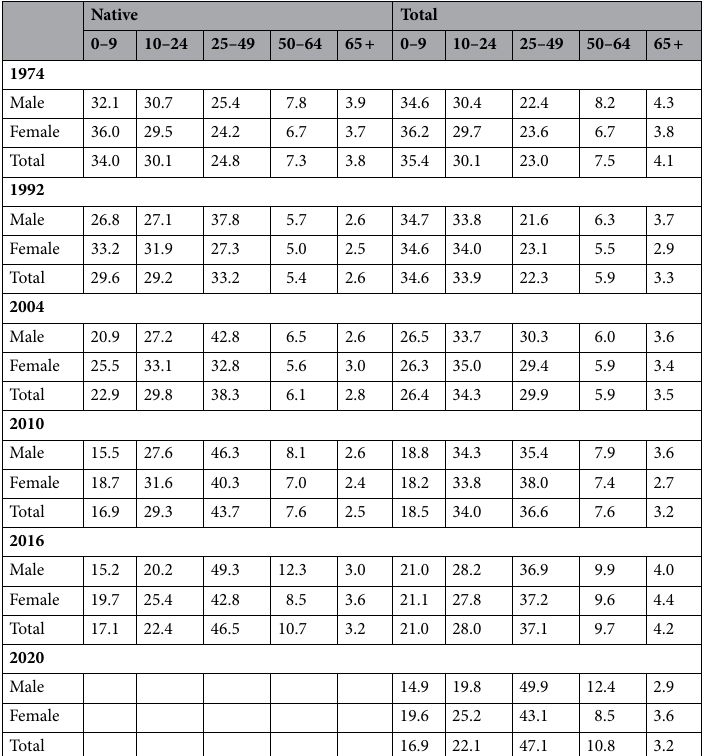
Table 1. Percentages of population by broad age groups, total and